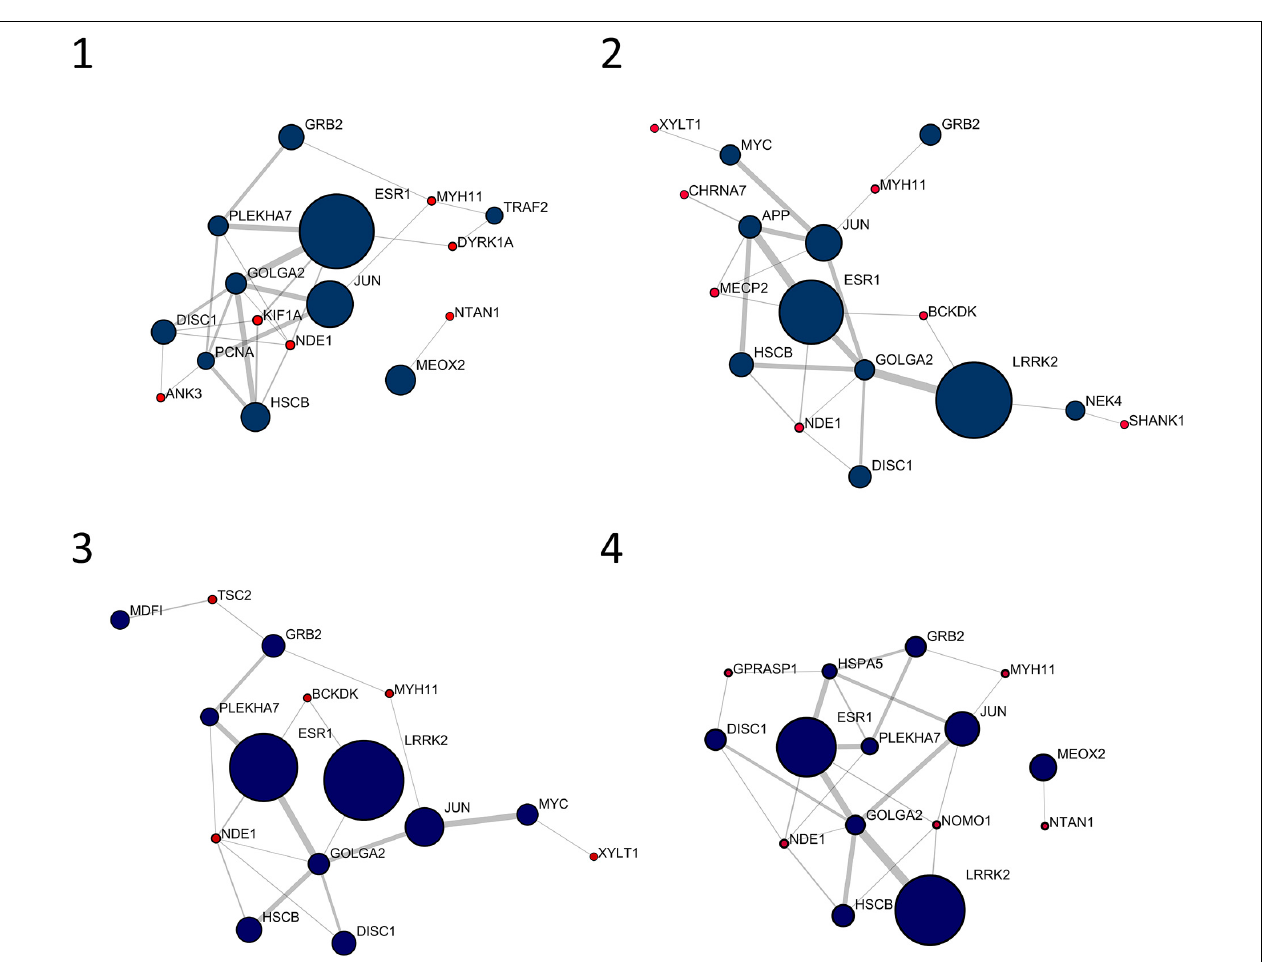
FIGURE 1 | Top 10 nodes in terms of betweenness centrality and interacting signature nodes. Red nodes are genes from the individual gene signature and navy-blue nodes are their first interactors. Diameter and border width of nodes are proportional to betweenness centrality, whereas edge width is proportional to edge